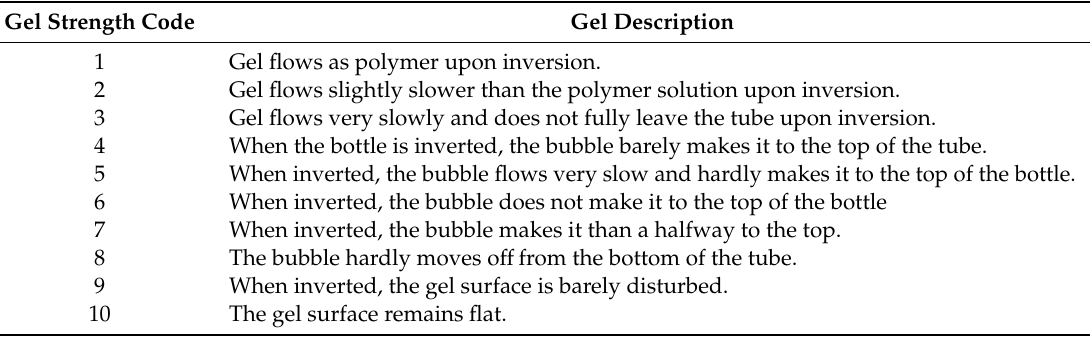
Table 2. Description of the gel strength based on Sydansk’s